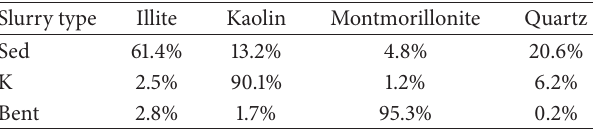
Table 2: Mineral composition